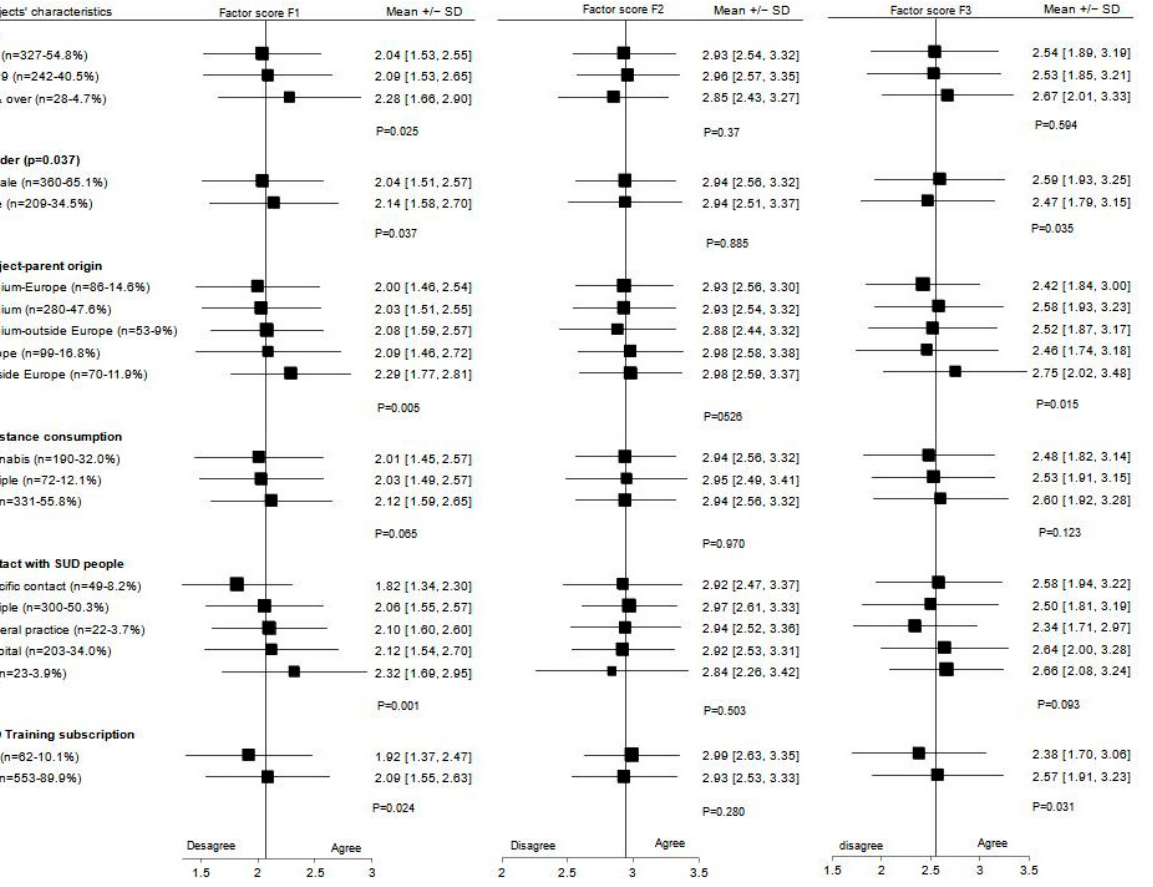
Figure A1. Mean ± SD of factor scores according to subjects’ sociodemographic characteristics, drug consumption and training. The factor score is the mean of items with loading >|0.30|. The vertical line corresponds to the overall mean of the factor. p -values: One-way ANOVA, F-test or t -test. Factor score 1 ( left ) “Stereotypes and moralism”; age: One-way ANOVA, test for linearity. Subject-parent origin: after Bonferroni correction, outside Europe vs. Belgium: p = 0.003, vs. Belgium–Europe: p = 0.007; all other comparisons are NS. Contact with SUD people: after Bonferroni correction, “Specific contact” differs significantly from “None” ( p = 0.003), “Hospital” ( p = 0.003) and “Multiple” ( p = 0.040). Factor score 2 ( middle ) “Treatment optimism”. Factor score 3 ( right ) “Specialized treatment” according to subjects’ sociodemographic characteristics, drug consumption and SUD training. Subject-parent origin: after Bonferroni correction, outside Europe vs. Belgium–Europe = 0.019 vs. Europe: 0.049; all other comparisons are